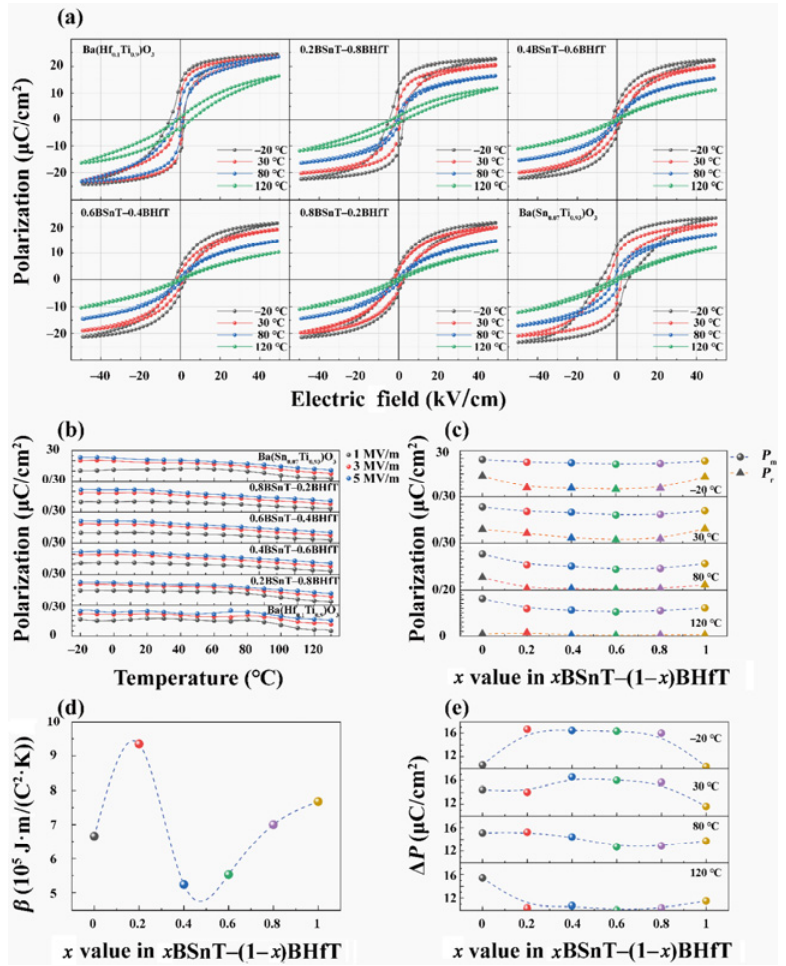
Fig. 3 (a) P – E hysteresis loops as a function of applied electric field and temperature at 10 Hz for x BSnT–(1 − x )BHfT. (b) as a function of temperature at 1, 3, and 5 MV/m. (c) (d, e)  and  P as a function of x ,